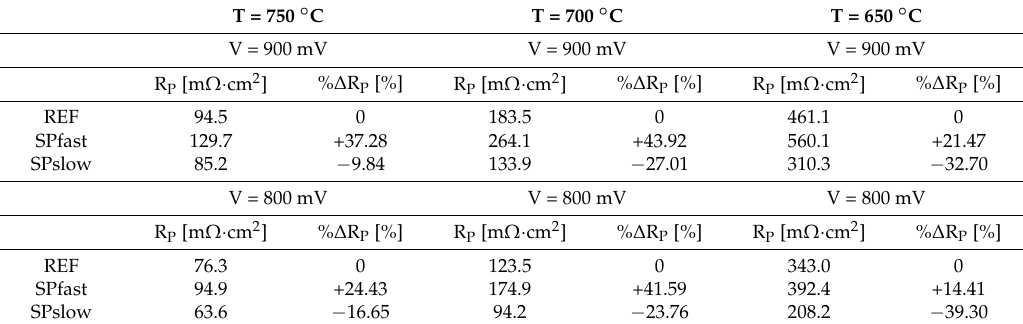
Table 5. Measured values of the polarization resistance R P for the tested